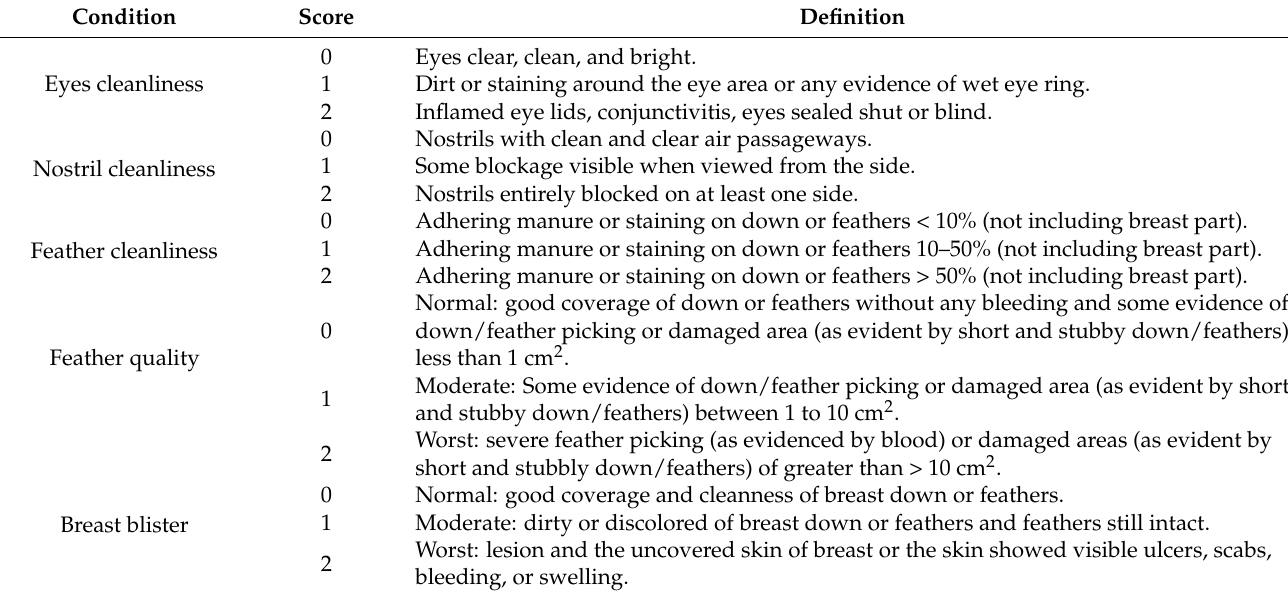
Table 1. The criterion of the physical condition score in